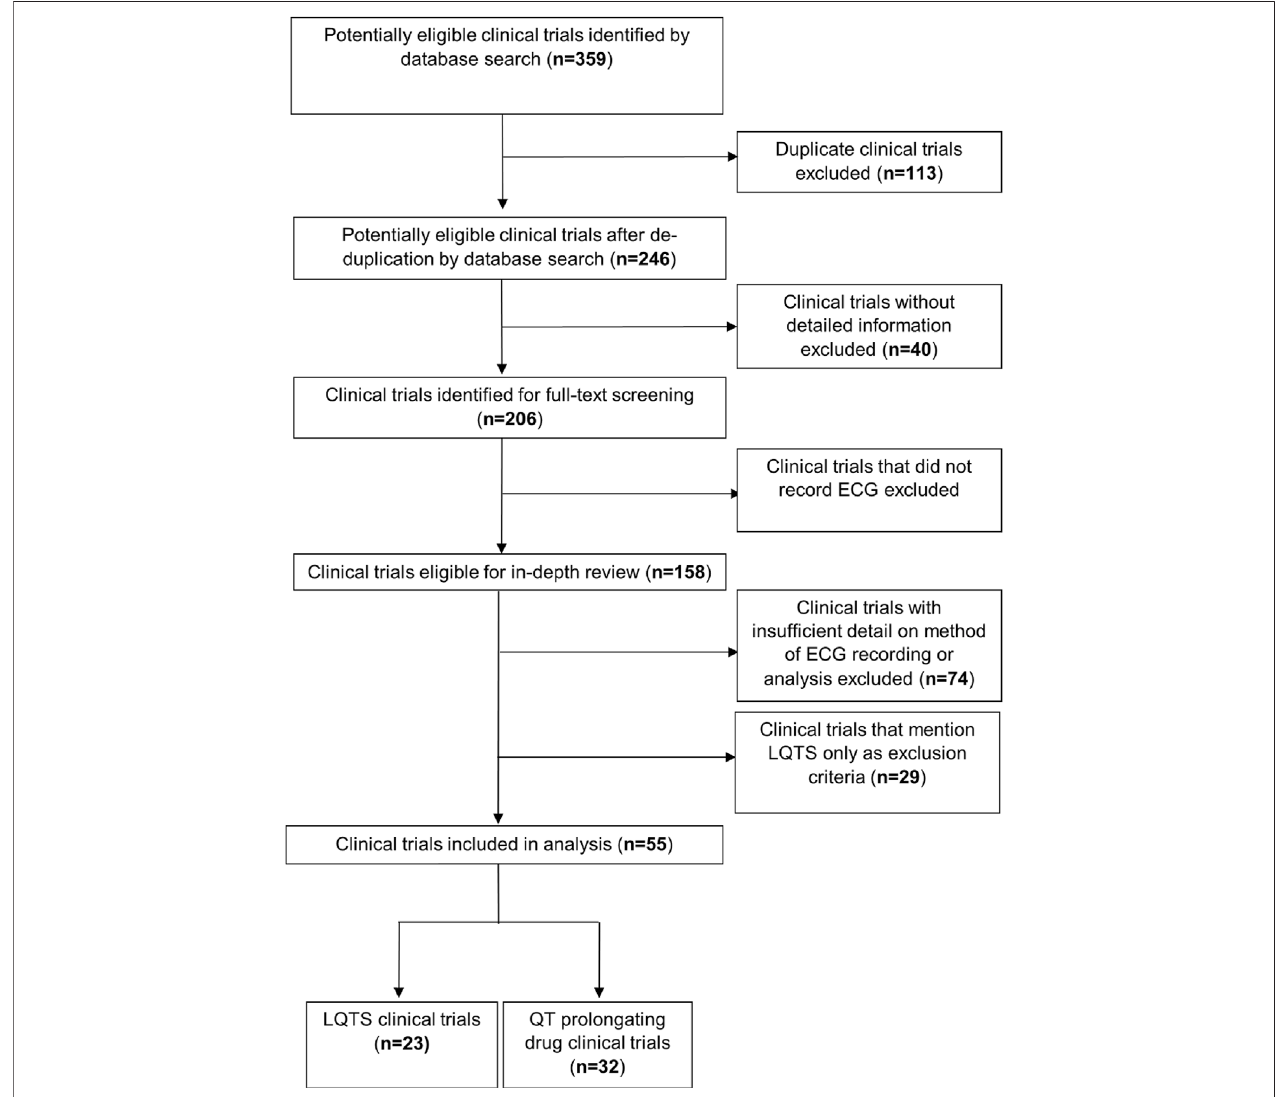
FIGURE 2 | Flowchart outlining the protocol for trial selection in this study. Trials were downloaded from the EU (https://www.clinicaltrialsregister.eu) and the US (https://clinicaltrials.gov/) registers.